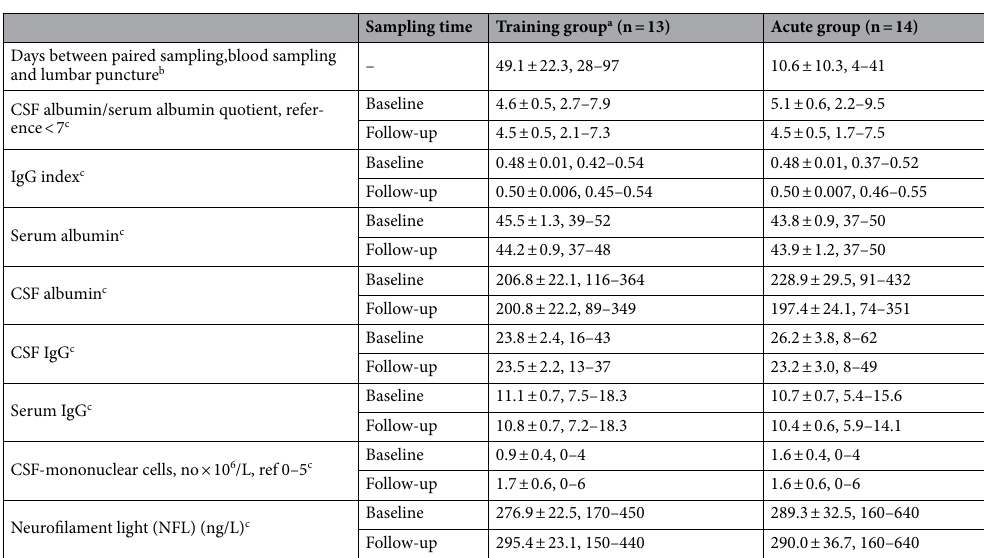
Table 2. Cerebrospinal fluid (CSF) routine markers and neurofilament light (NFL) before and after intervention. a One individual’s baseline sample in the ‘moderate-intensity’ exercise group was excluded because of a laboratory test failure regarding all results except of NFL and CSF mononuclear cells. b Mean ± s.d., range. c Mean ± s.e.m.,